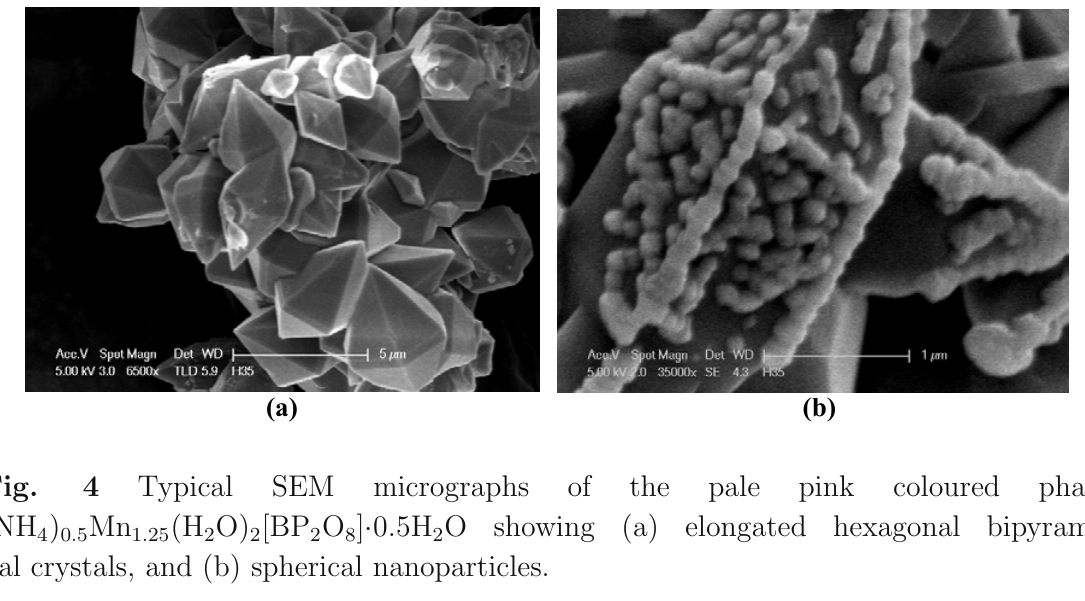
Fig. 4 Typical SEM micrographs of the pale pink coloured phase (NH 4 ) 0 . 5 Mn 1 . 25 (H 2 O) 2 [BP 2 O 8 ] · 0.5H 2 O showing (a) elongated hexagonal bipyrami- dal crystals, and (b) spherical